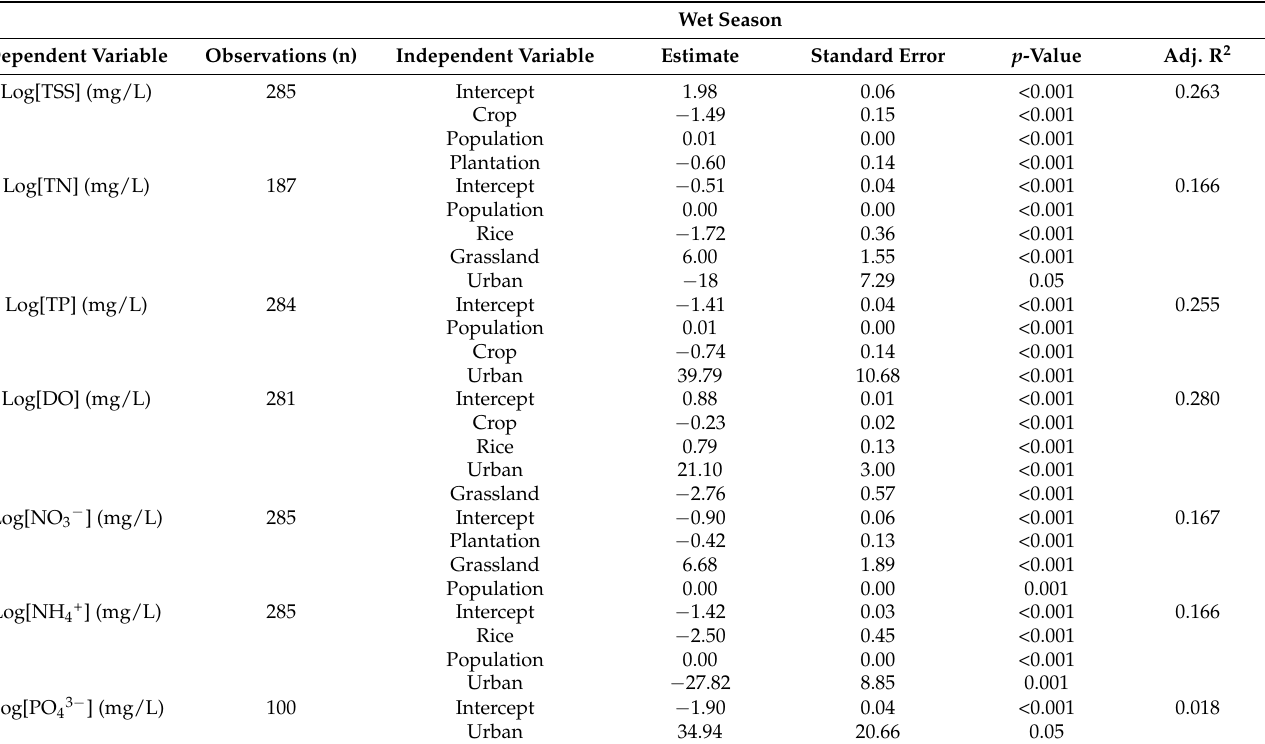
Table 2. Multiple regression models with anthropogenic drivers in the wet season.